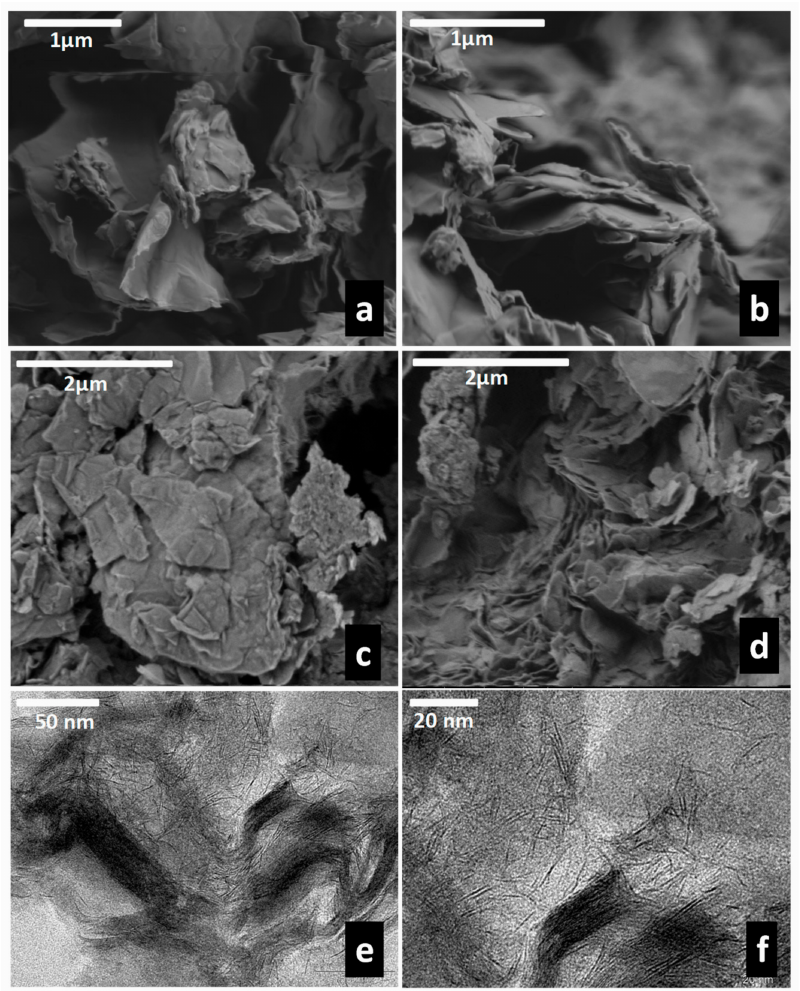
Figure 11. FE-SEM images of the pristine Co-LSH ( a , b ), and the Z-LSH_ cppt ( c ) and Z-LSH_ie ( d ) biohybrids. TEM images of Z-LSH_ie biohybrid ( e , f